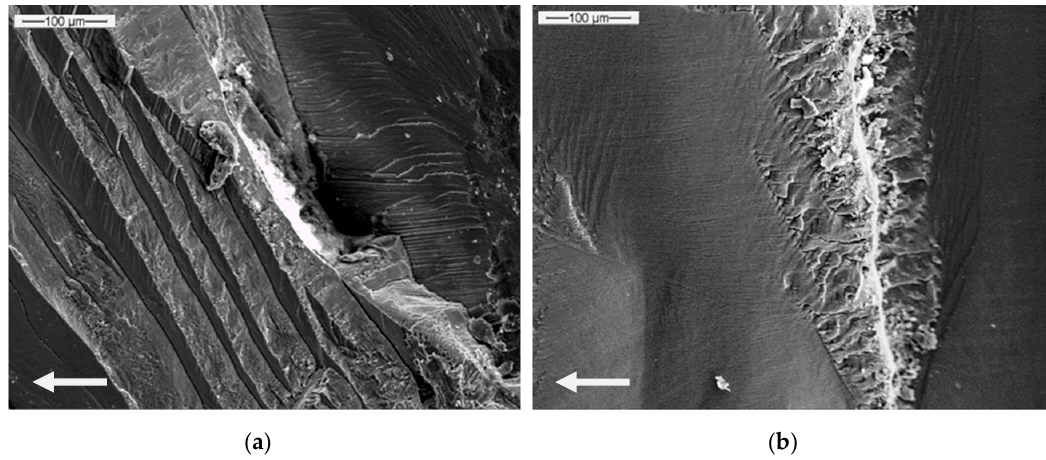
Figure 12. Crack surface at mid-thickness before ( a ) and after ( b ) transition, respectively at Δ K = 20 MPa √ m and at Δ K = 40 MPa √ m, T β + 75 °C for 1 h 30 min heat treatment, propagation according to the arrow.